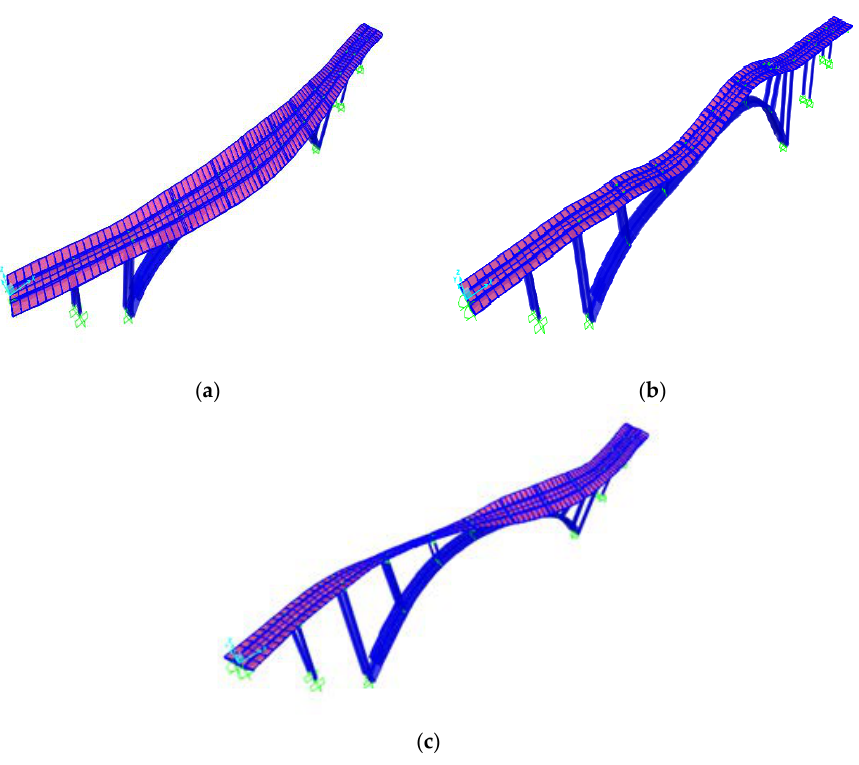
Figure 8. CsiBridge output for the first three modes of vibration for the model RC arch bridge. ( a ) 1st mode (Transverse & symmetric torsion); ( b ) 2nd mode (Longitudinal); ( c ) 3rd mode (Transverse & anti-symmetric vertical torsion).